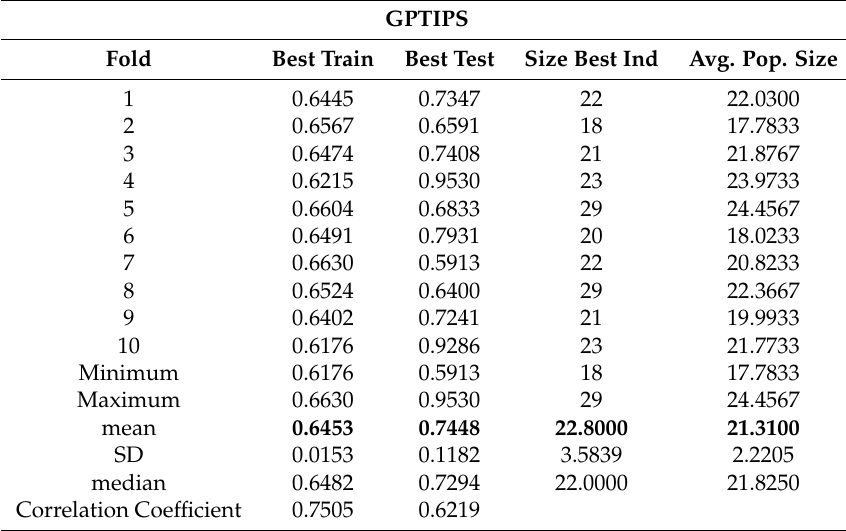
Table 6. RMSE for the 10-fold cross validation performance of GPTIPS on the 1–4 scale